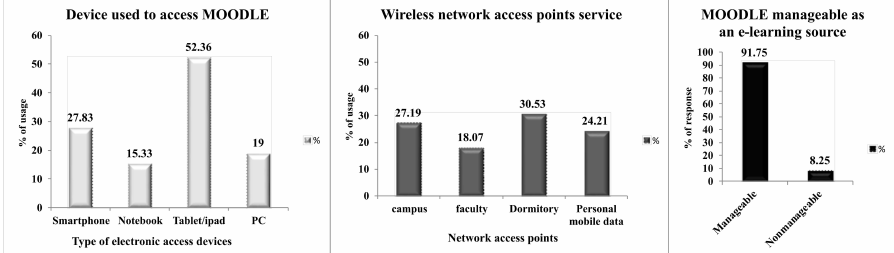
Figure 2. Students’ responses on e-device usage for Moodle learning (left), network access points service (middle), and the closed question as to whether Moodle is manageable as an e-learning source